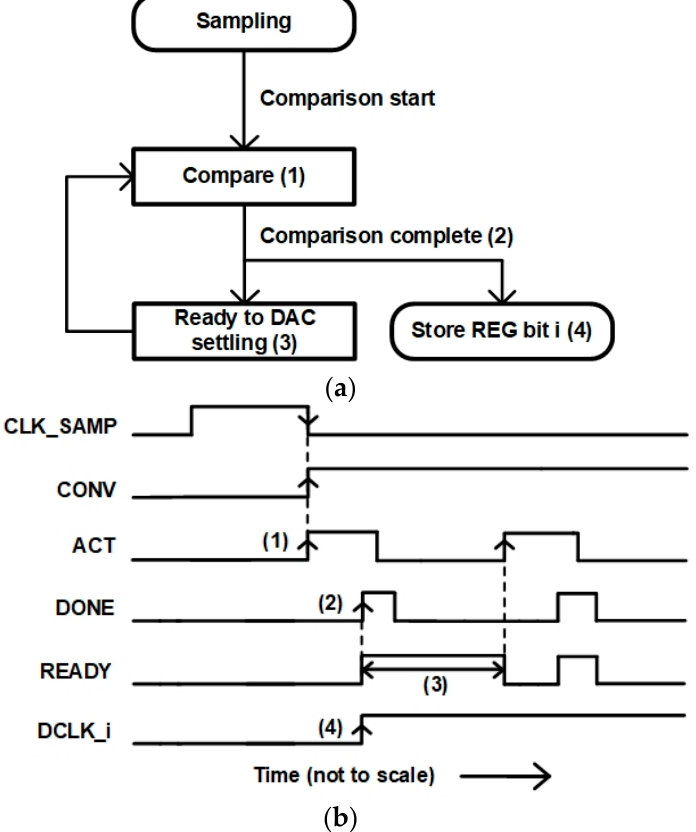
Figure 11. ( a ) State and ( b ) timing diagrams of the asynchronous timing controller.